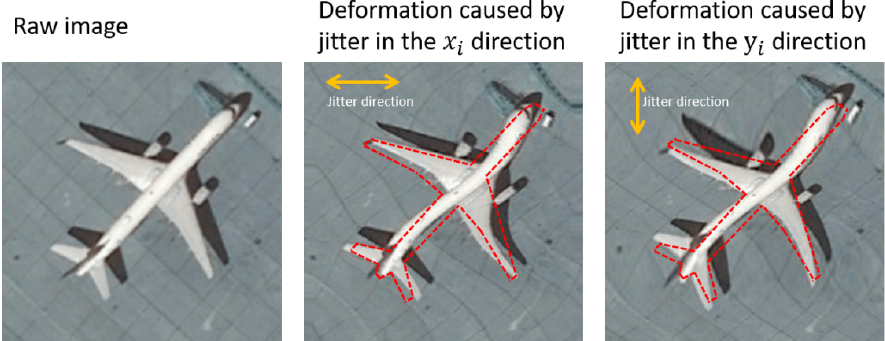
Figure 2. Image deformation caused by jitter in the x i and y i